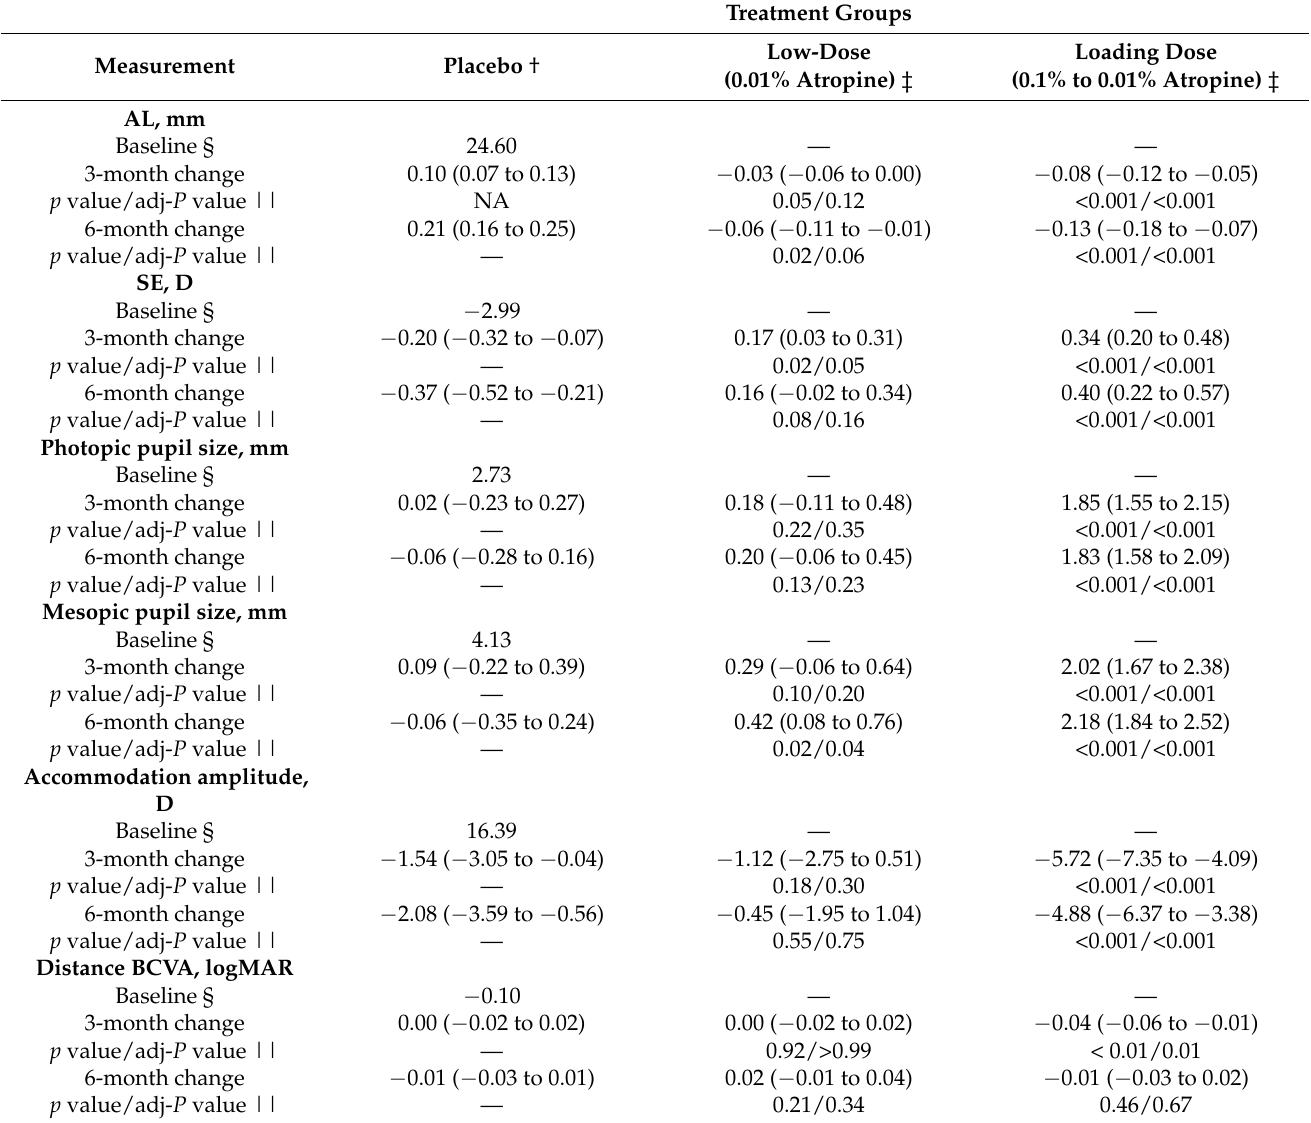
Table 2. Changes in refractive and visual parameters over six months based on linear mixed models. Treatment